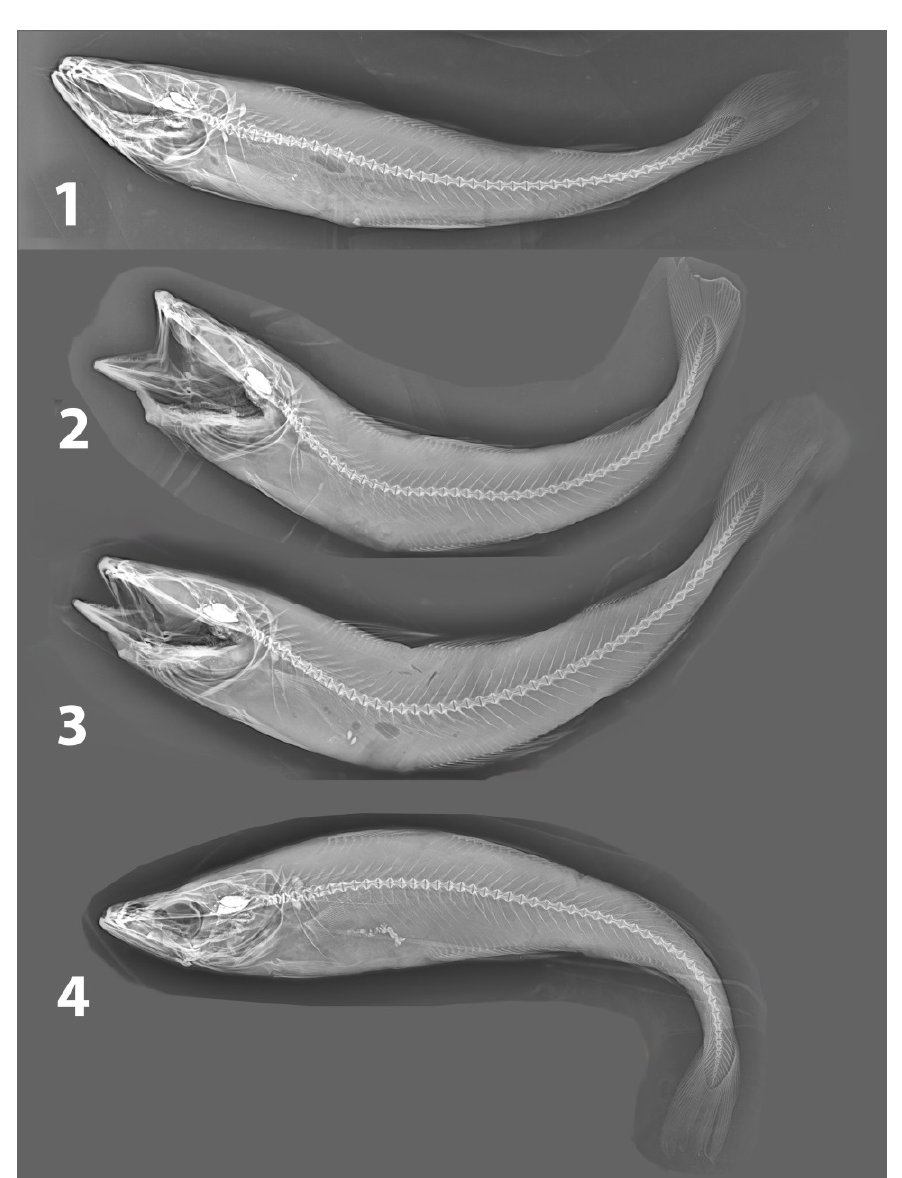
Figure 3. X-ray images of walleye pollock Gadus chalcogrammus from the Laptev Sea: ( 1 ): IORAS 04464, ( 2 ): IORAS 04465, ( 3 ): IORAS 04466, ( 4 ): IORAS 04467 .